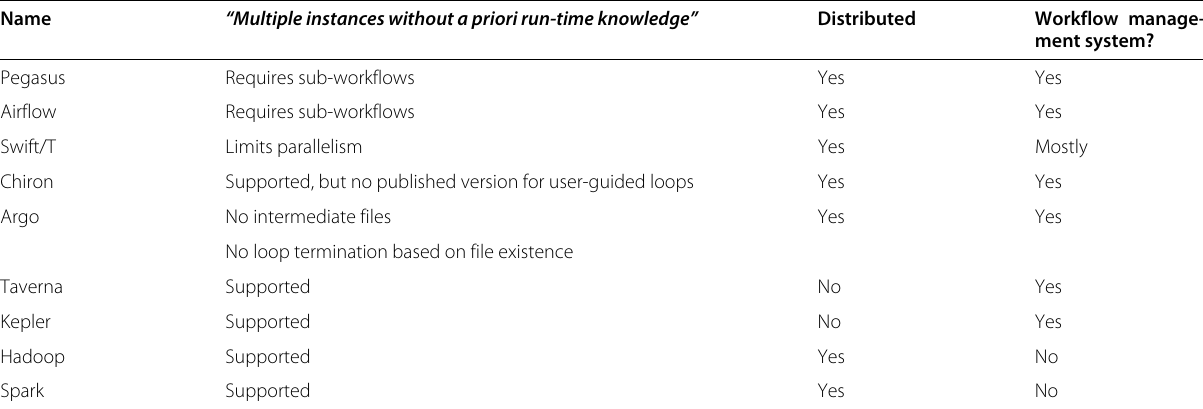
Table 1 Differences between existing workflow management